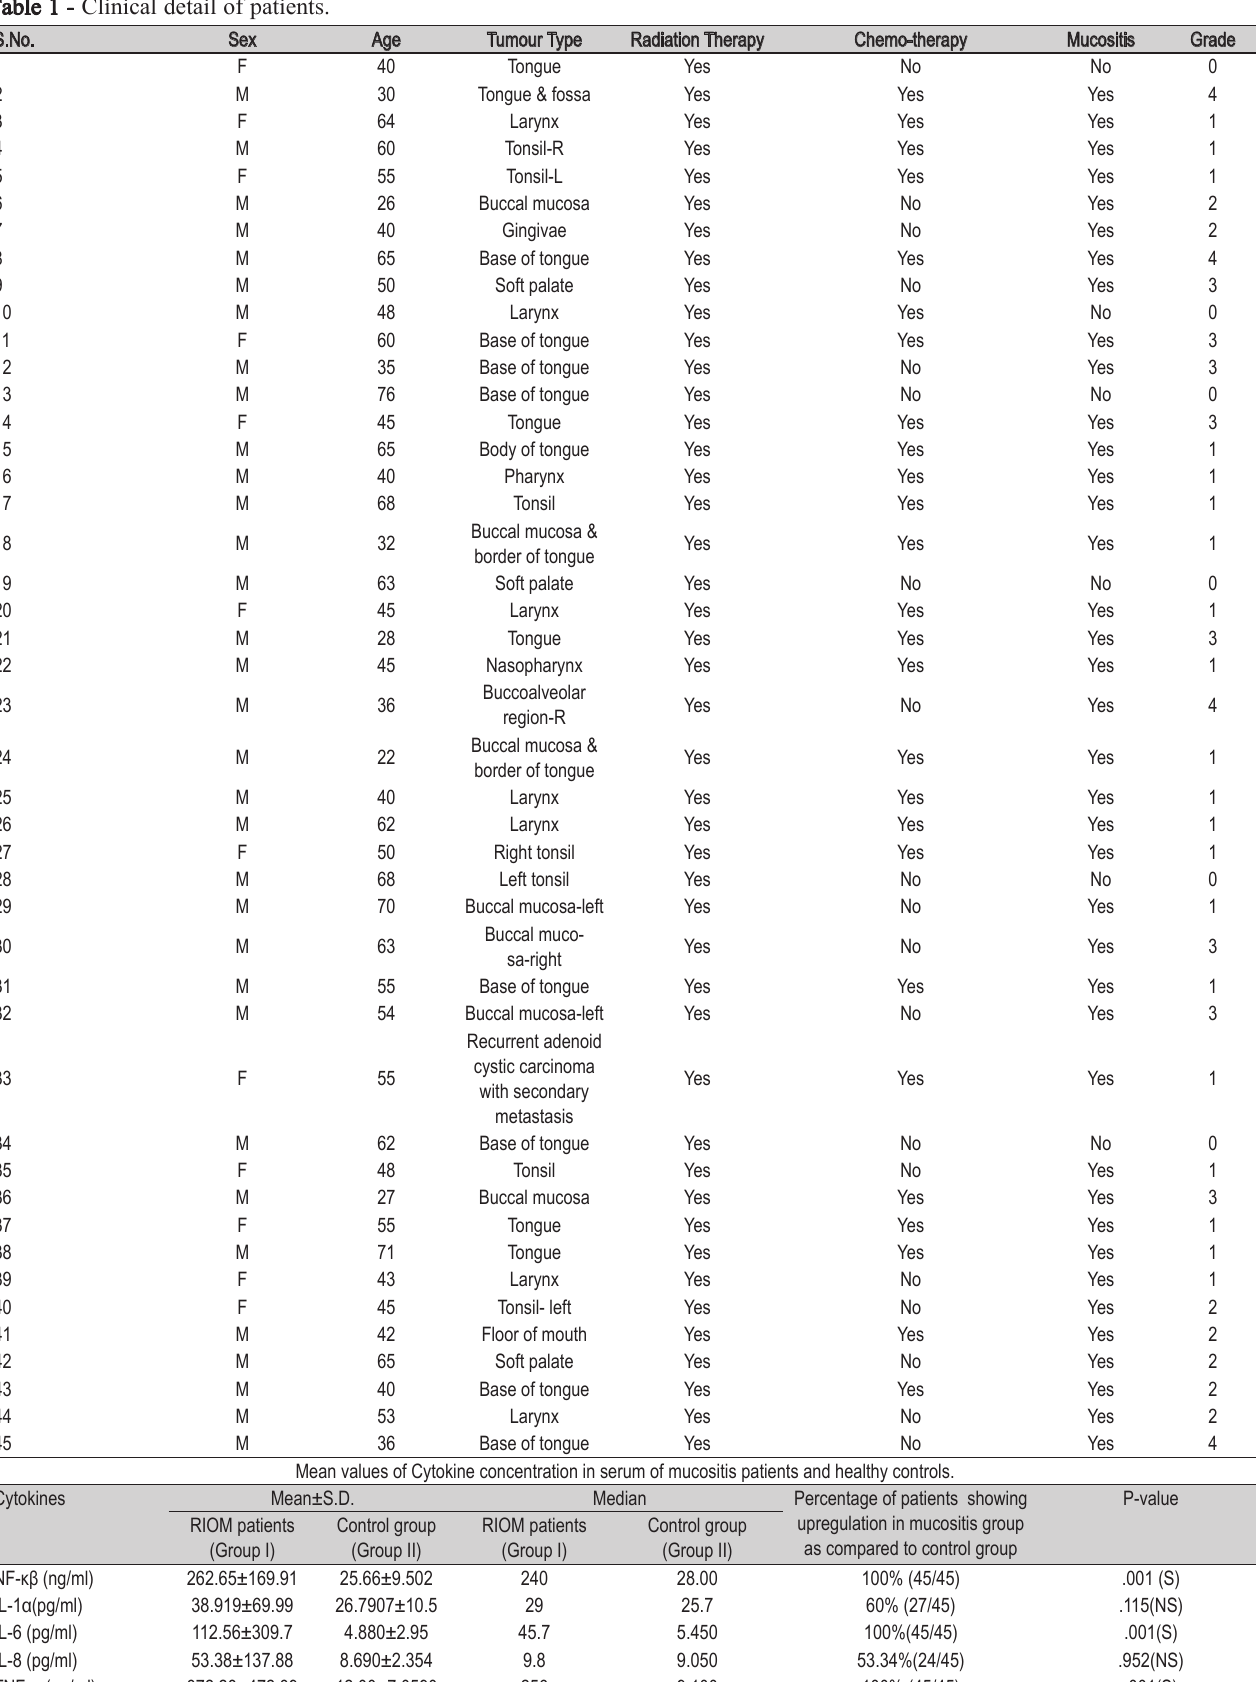
Table 1 - Clinical detail of